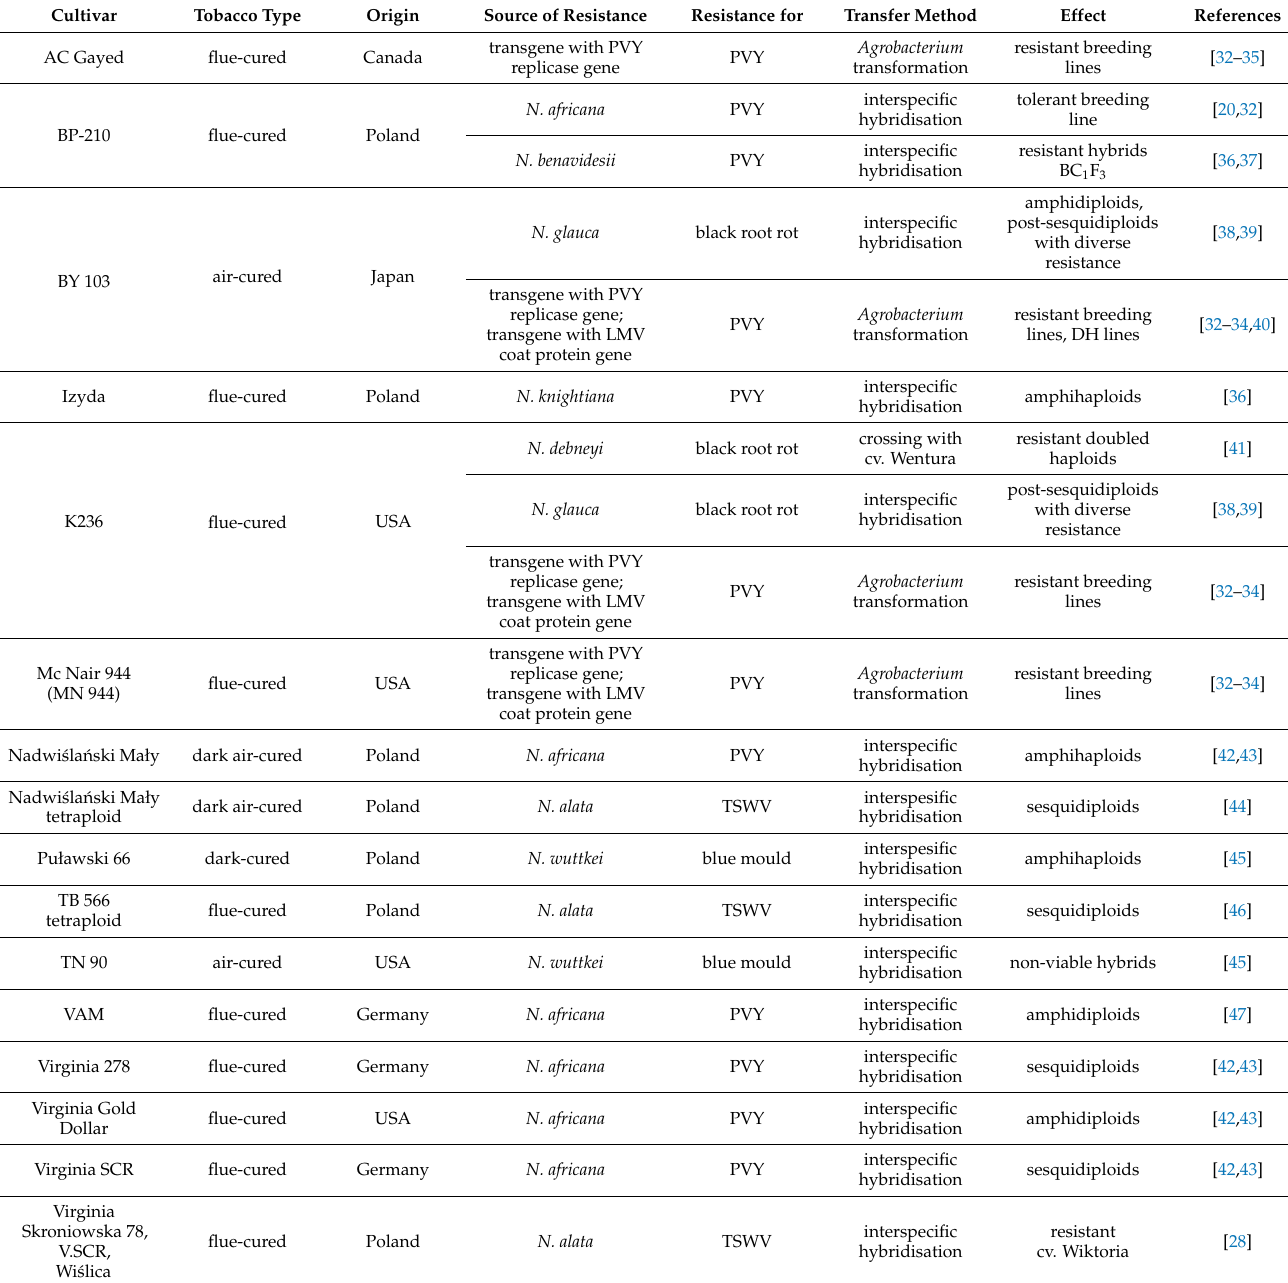
Table 2. The use of tobacco cultivars from the Polish germplasm collection in